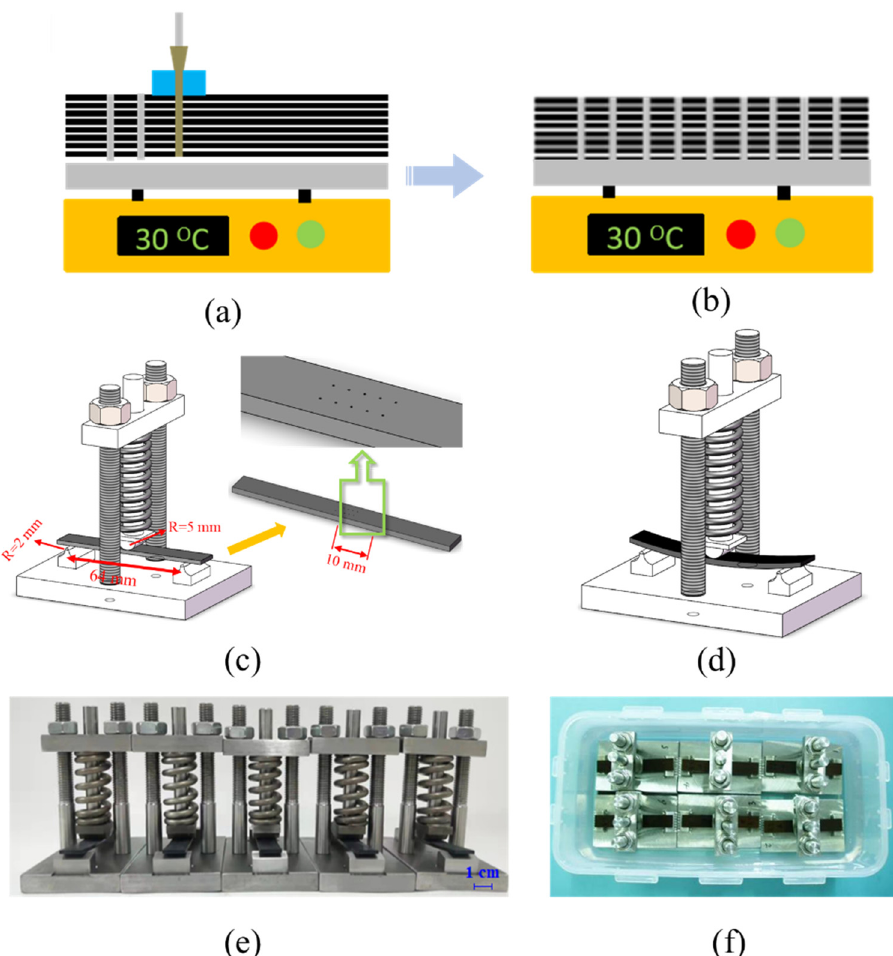
Figure 1: ( a – b ) Scheme of Z - pin plantation; ( c ) illustration of self - designed fi xture with samples before compressing spring; ( d ) illustration of self - designed fi xture with samples after compressing spring; ( e ) composite samples under fl exural load; and ( f ) composite samples under moisture coupled with the fl exural